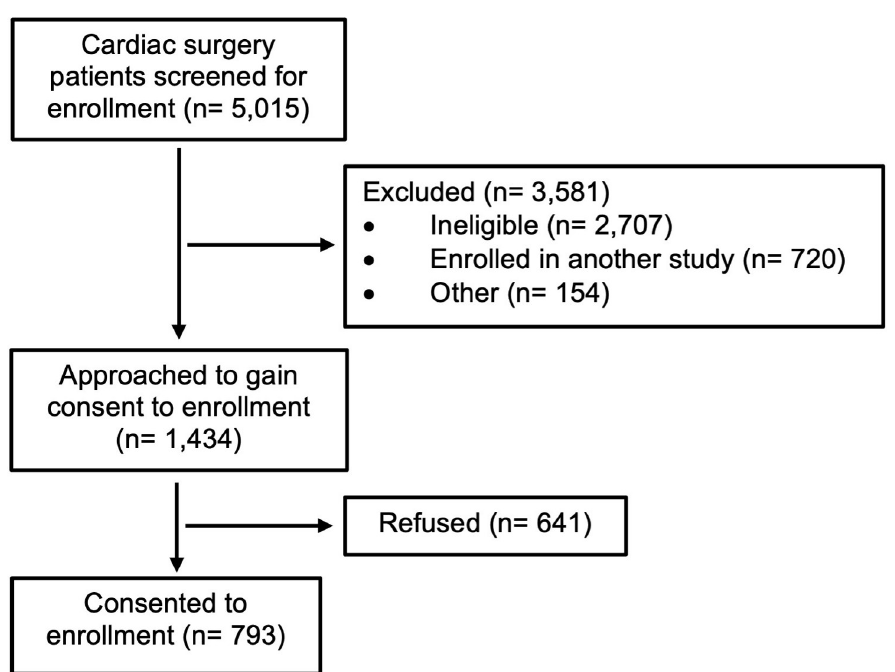
Fig 1. Patient screening and enrollment for the NO/AKI and MINDDS trials. All patients presenting for cardiac surgery were screened for enrollment. Patients were excluded from the trials if they were found to be ineligible based on inclusion or exclusion criteria, enrolled in another study, or for various other